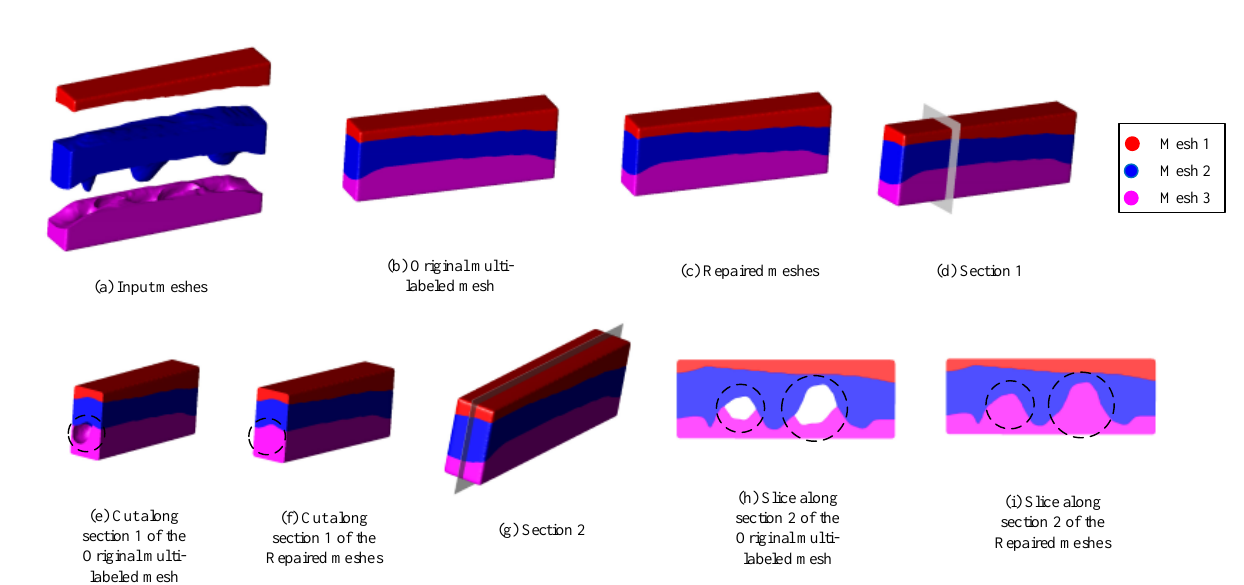
Figure 7. The multi-labeled mesh with input three sub-meshes.